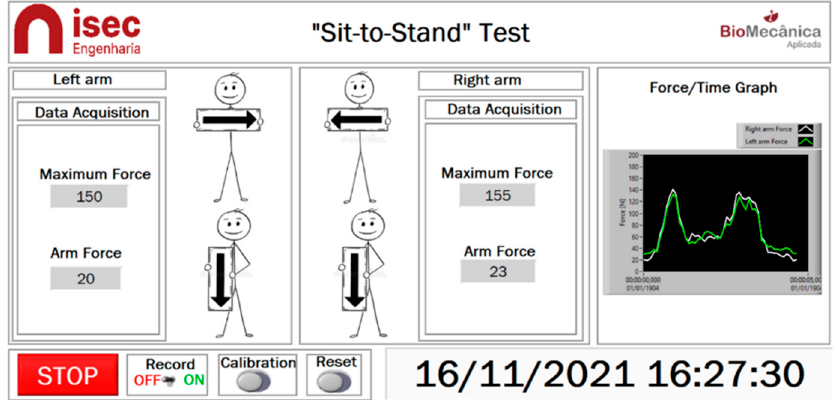
Figure 1. Visualization of user interface of the application.